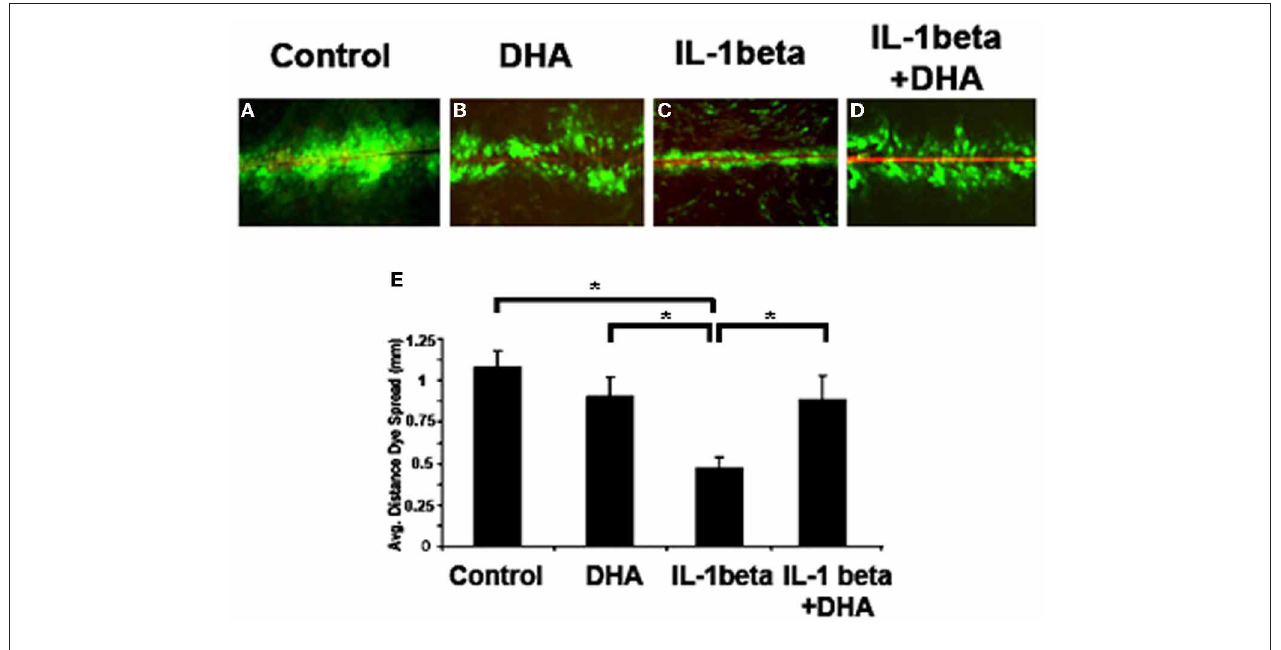
FIGURE 1 | Dye spread in MDCK cells. Lucifer Yellow (LY, green) easily passed through gap junctions in control cells (A) , an event not altered by DHA treatment alone (B) . In contrast IL-1 β treatment caused a significant decrease in coupling (C) which was inhibited